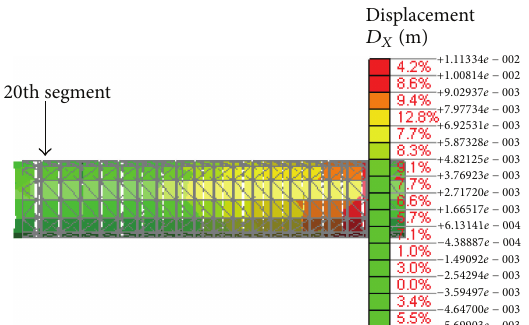
Figure 5: Displacement nephogram of the segments.